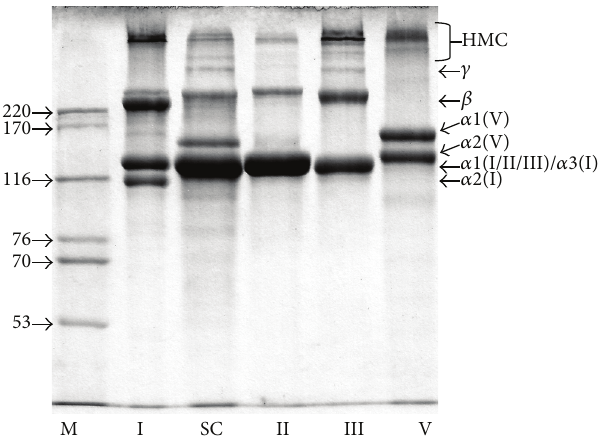
Figure 1: SDS-PAGE pattern of collagen from the skin of splendid squid (SC) under reducing condition. HMC, M, I, II, III and V denote high-MW cross-linked components, high-MW protein markers, and collagen type I, type II, type III, and type V, respec- tively.